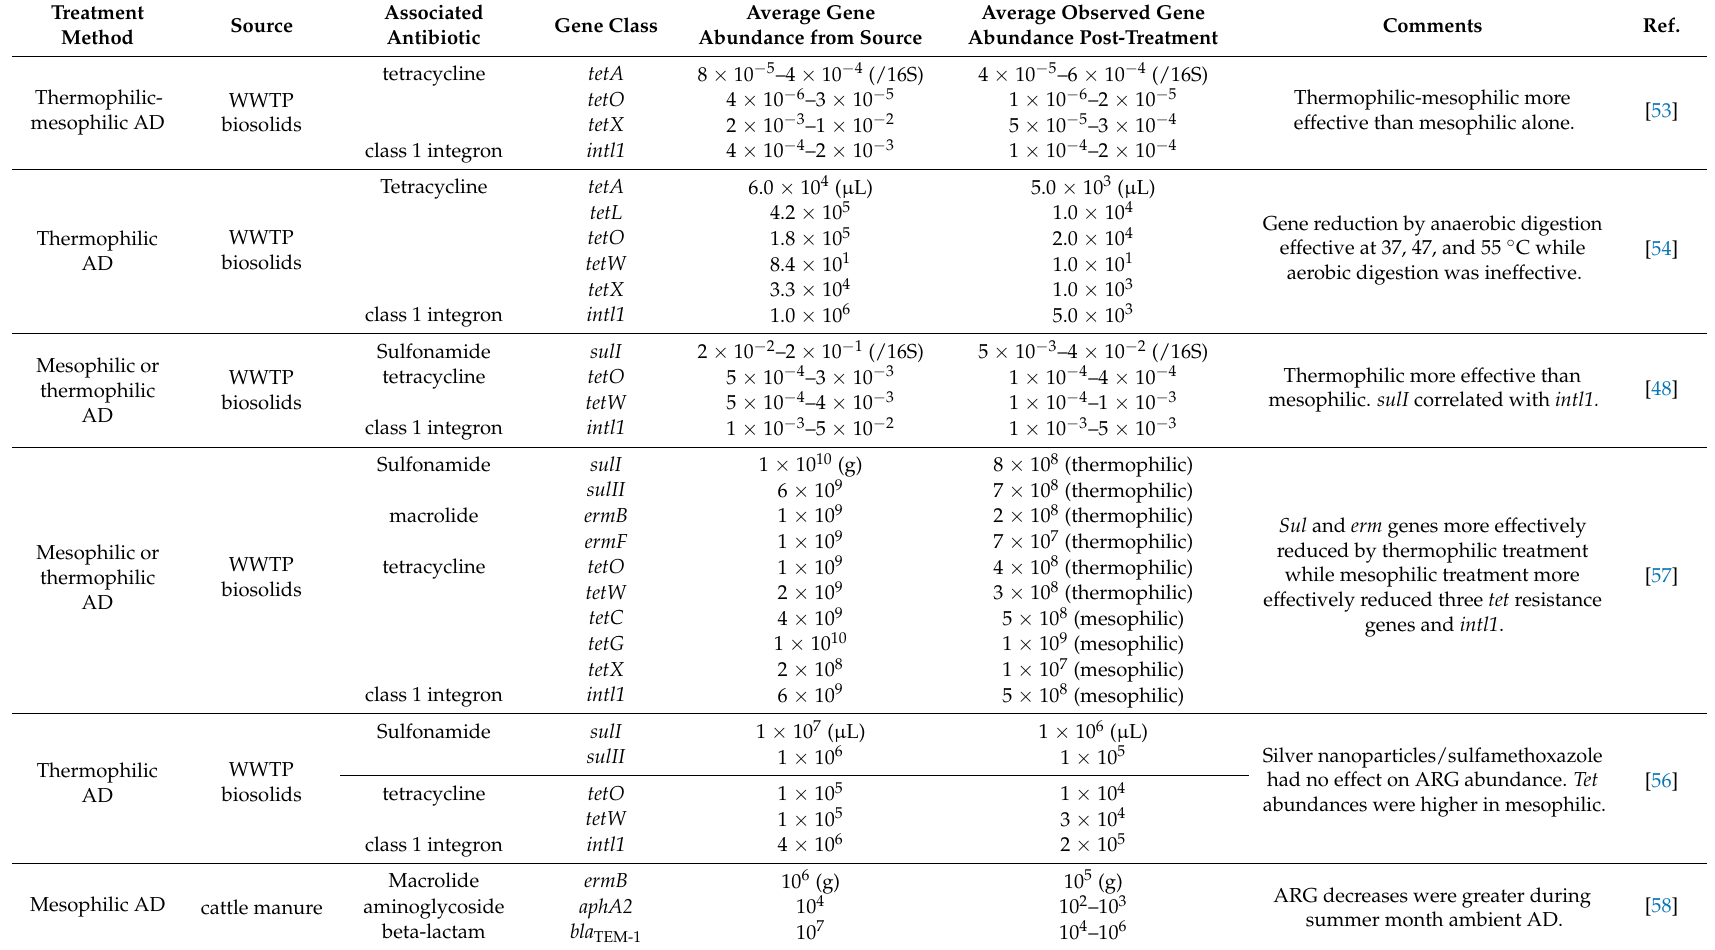
Table 1. Average abundance of antibiotic resistance genes (ARGs) in anaerobic digester (AD) and membrane bioreactor (MBR) effluents and their